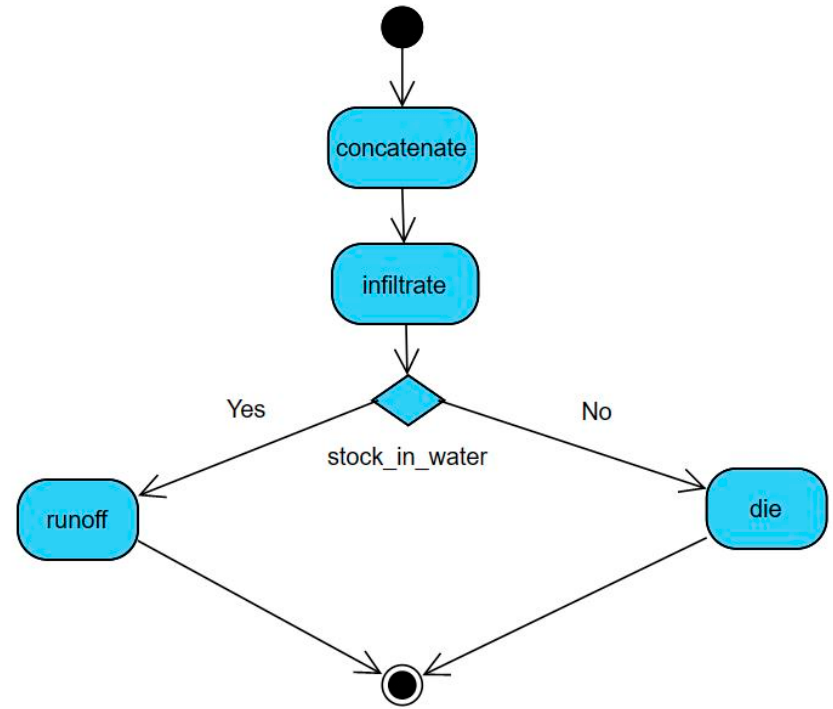
Figure 6. Simplified activity diagram of the hydrological agent.